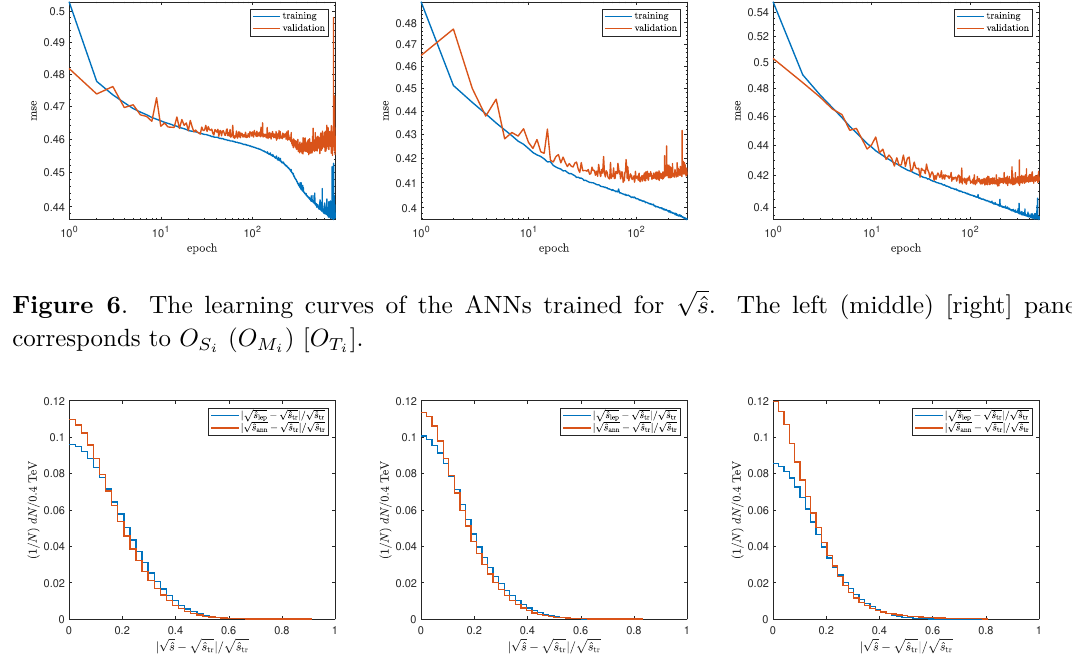
√ ˆ s | . The left (middle) [right] panel corresponds to